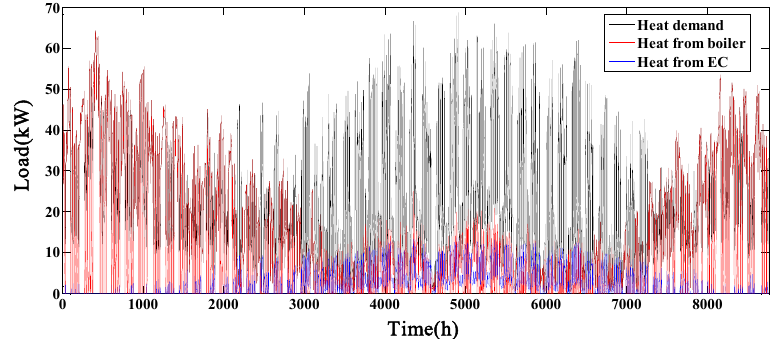
Figure 9. Annual heat distribution of the RES–CCHP system.